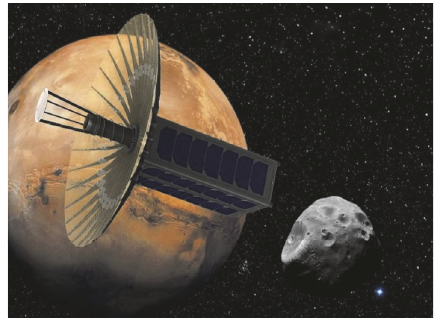
Figure 1: A CubeSat with Ka-band reflector antenna for deep space mission